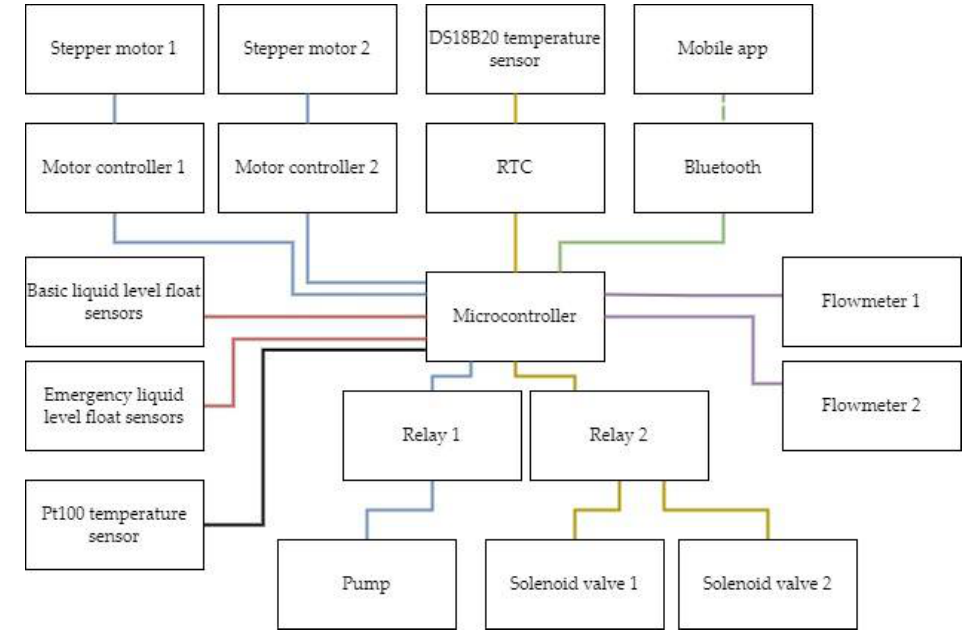
Figure 2. Simplified circuit diagram of the AWES.